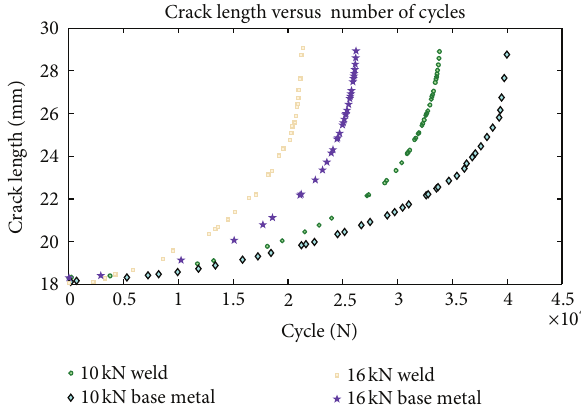
Figure 4: Relationships between crack length and number of cycles.